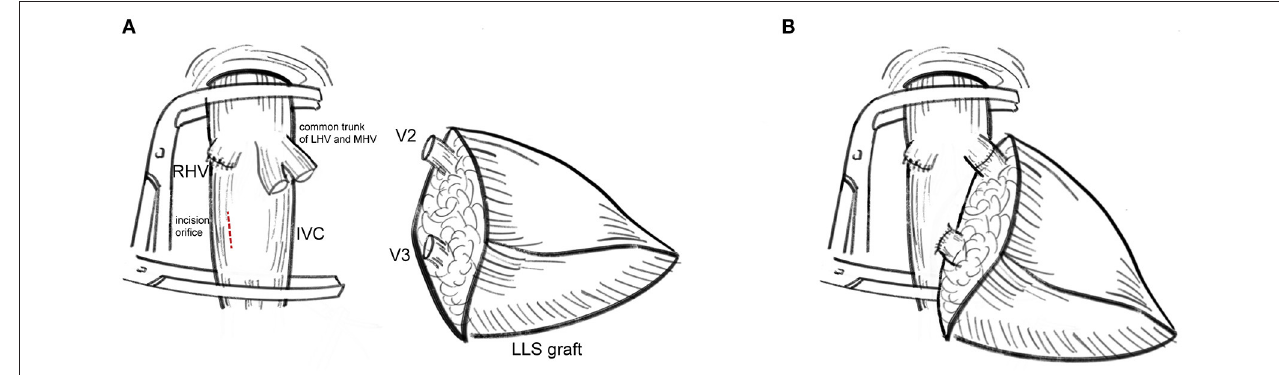
FIGURE 1 | Procurement of the modified dual hepatic vein anastomosis. (A) V2 was anastomosed to the stump of MHV and LHV while V3 was anastomosed to the incision orifice at the right of the middle line of IVC. (B) The cut surface of liver graft was adjusted to slightly oblique upward to prevent regenerated LLS graft oppress-reconstructed hepatic veins. The modified dual hepatic vein anastomosis leave enough space for graft